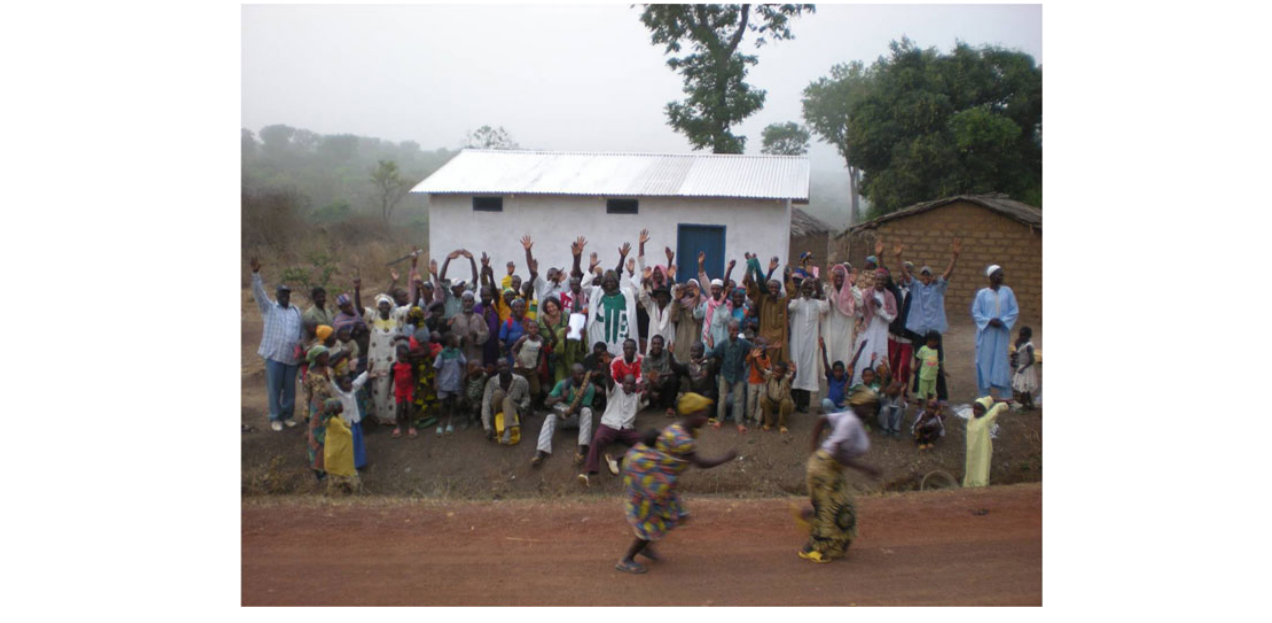
Fig. 5. Guiding the hope of beefarmers in Ngoundal. Collection center inauguration with village suppliers, March